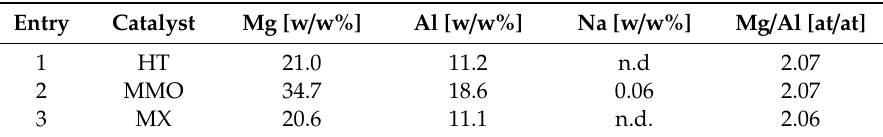
Table 2. Results of the ICP-AES analysis of the prepared